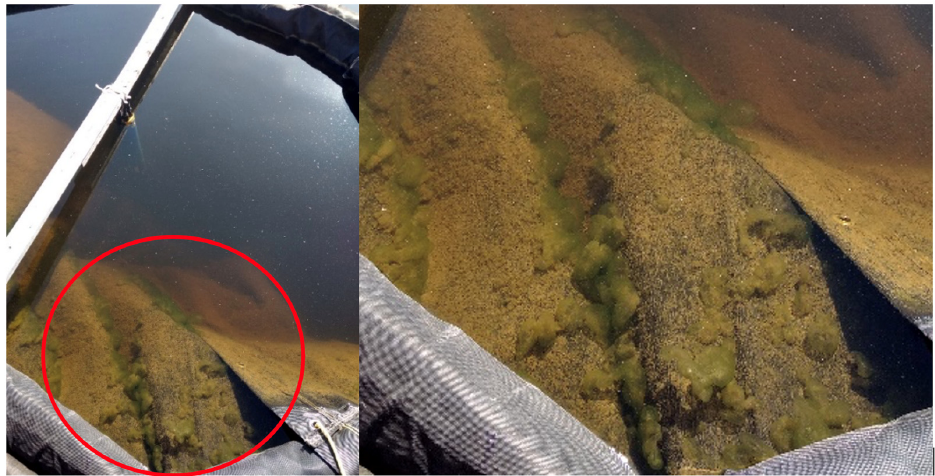
Figure 6. Reported visible phytoplankton accumulation in the control enclosed area in 2019 summer.